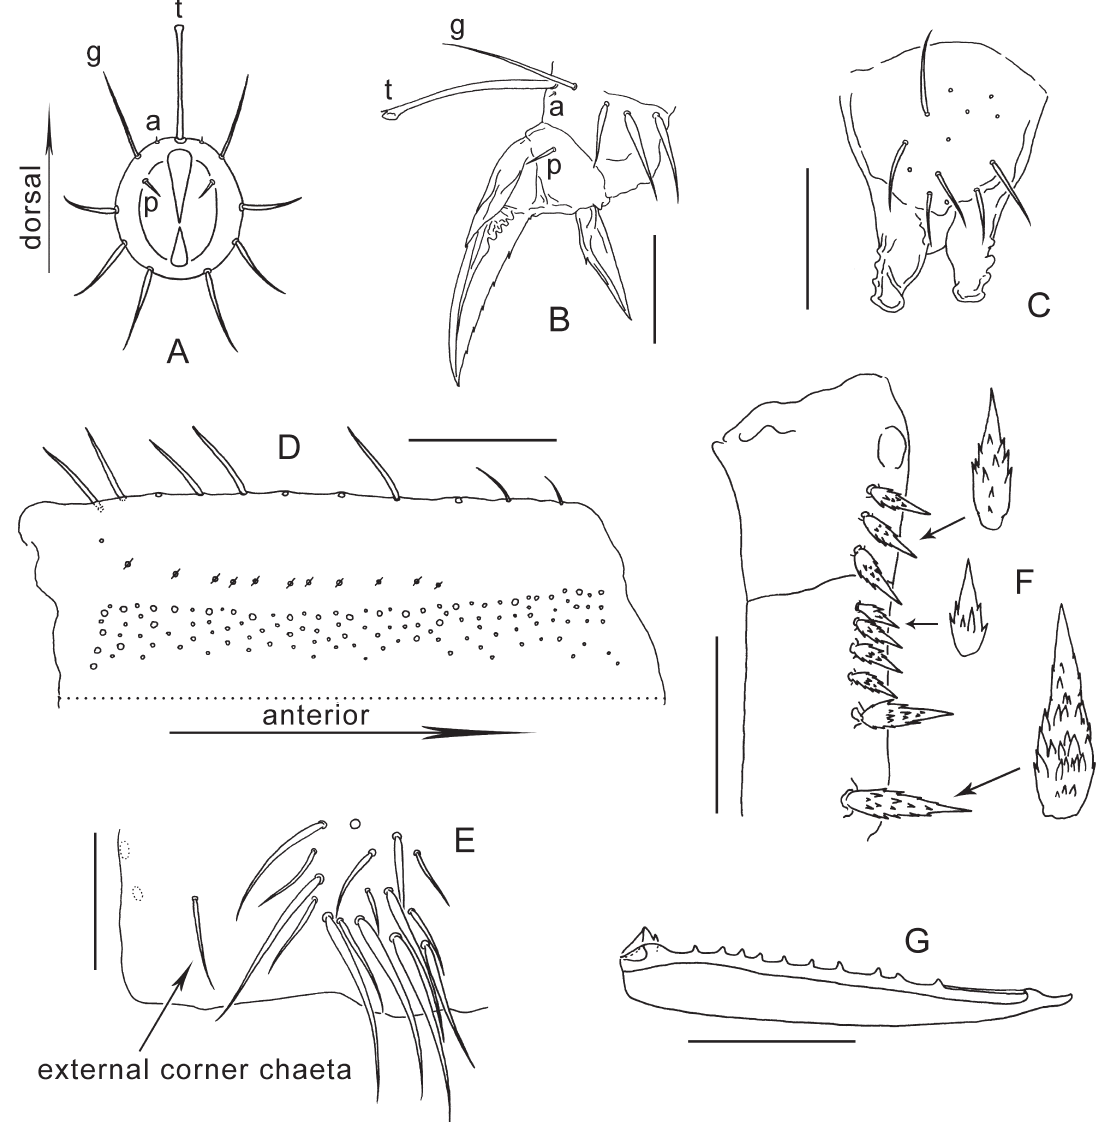
Fig. 3. Tomocerus ocreatus Denis, 1948. A . Diagram of tibiotarsal distal chaetae (distal view; t = tenent hair; a = accessory chaeta; g = guard chaeta; p = pretarsal chaeta, same as below). B . Hind claw (lateral view). C . Tenaculum (anterior view). D . Left side of manubrium (dorsal view). E . Disto-external corner of manubrium (dorsal view). F . Basal and middle subsegments of dens with dental spines (dorsal view). G . Mucro (dorso-inner view). Scale bars: B, C, E, G = 50 μm; D, F = 100